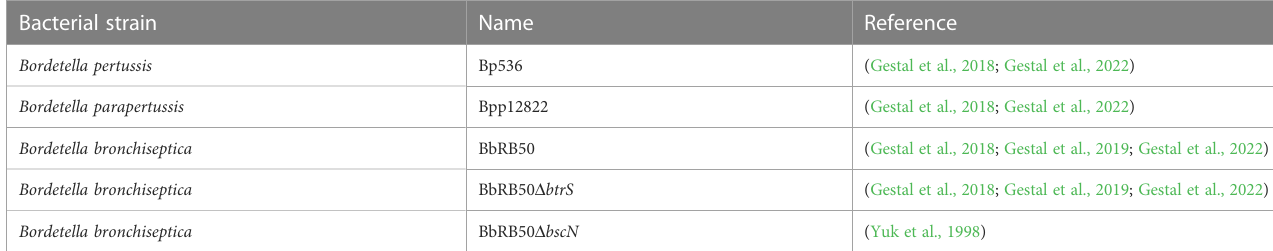
TABLE 1 Bacterial strains included in this